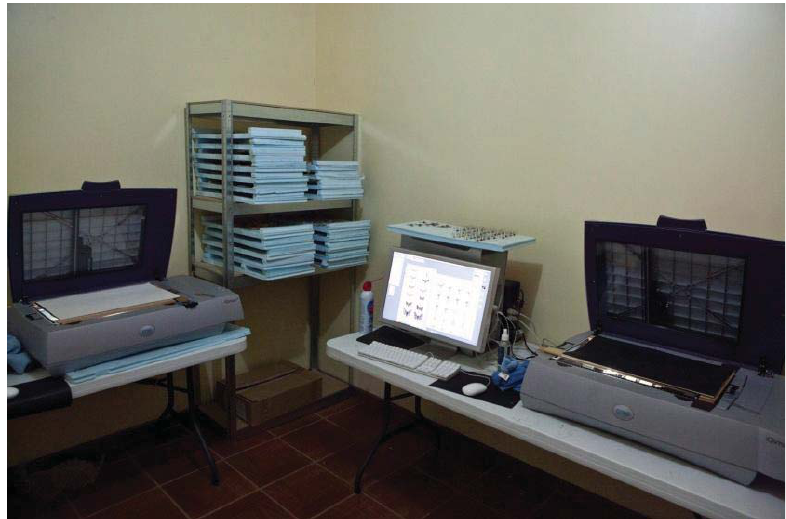
Figure 1. Two Creo scanners operating to process the night’s